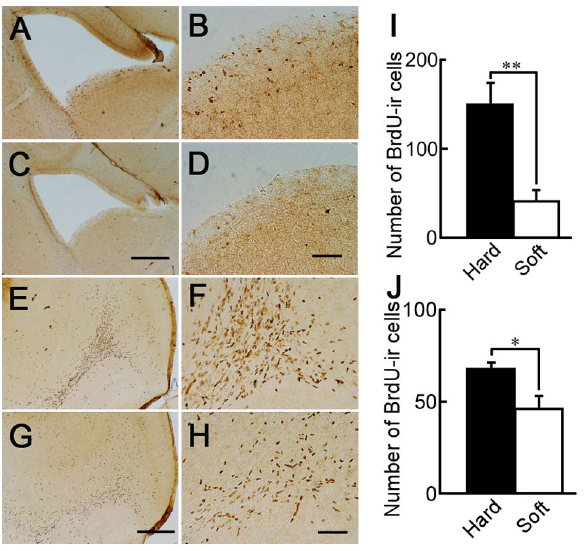
Figure 1. BrdU-ir cells in the SVZ and OB of mice fed a hard or soft diet. Sagittal sections of the SVZ (A–D) and OB (E–H) of mice fed a hard diet (A, B, E and F) or soft diet (C, D, G and H) for 1 month. Scale bar: 500 m m (C and G), 200 m m (D and H); I: the numbers of BrdU-ir cells at 600 m m thickness from Figure 108 of the mouse atlas (lateral 0.84 mm) of the SVZ to the lateral side of mice fed the hard diet (black column; n=3) or soft diet (white column; n=4). J: the number of BrdU- ir cells at 300 m m thickness from the section from Figure 108 of the mouse atlas (lateral 0.84 mm) of the OB to the lateral side of mice fed the hard diet (black column; n=5) or soft diet (white column; n=5). *: p , 0.05; **: p , 0.01. soft diet cannot recognize the odor of 50% butyric acid as undesirable.